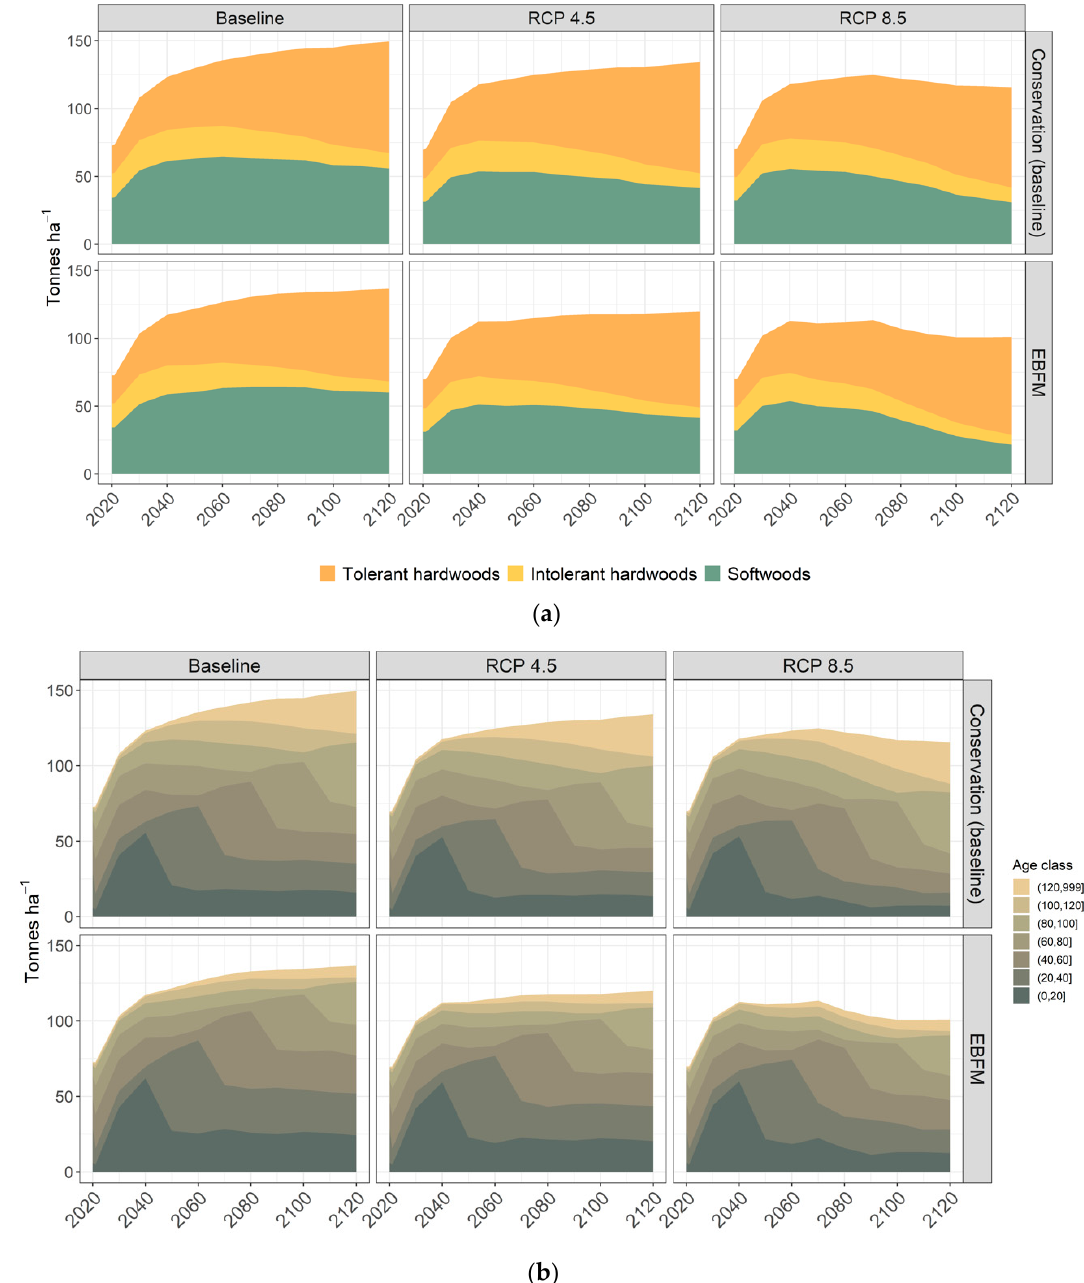
Figure 4. Evolution of ( a ) forest composition and ( b ) age classes of Maskinongé forests, in oven-dry tonnes·ha − 1 of above-ground biomass. Columns correspond to climate scenarios, and rows to management scenarios, i.e., conservation, and ecosystem-based forest management (EBFM). See Table 1 for list of species. Results are based on the average of five replicates.